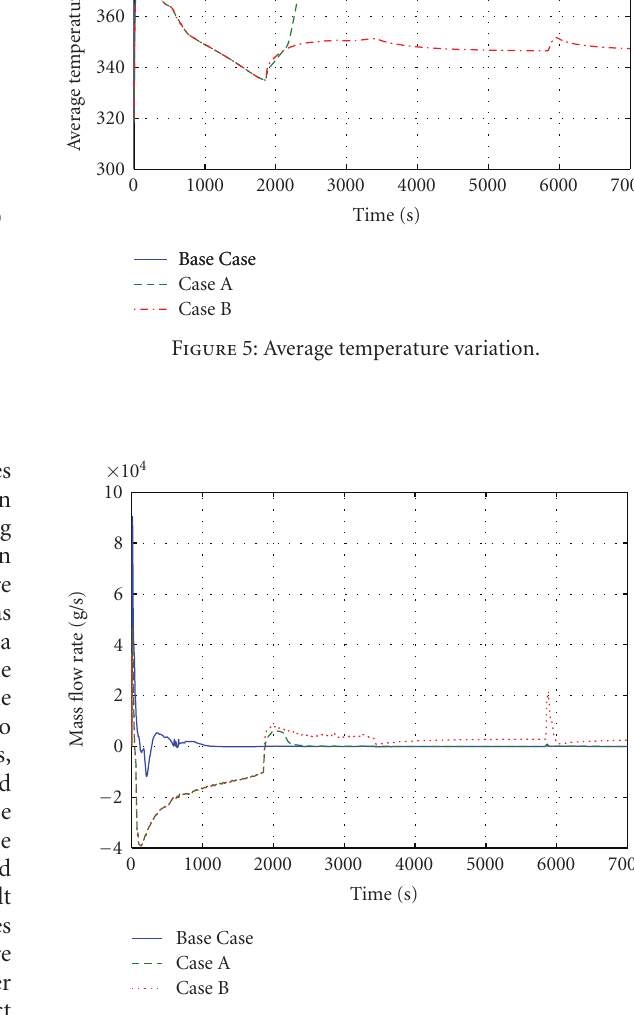
Figure 6: Bulk evaporation rate in all